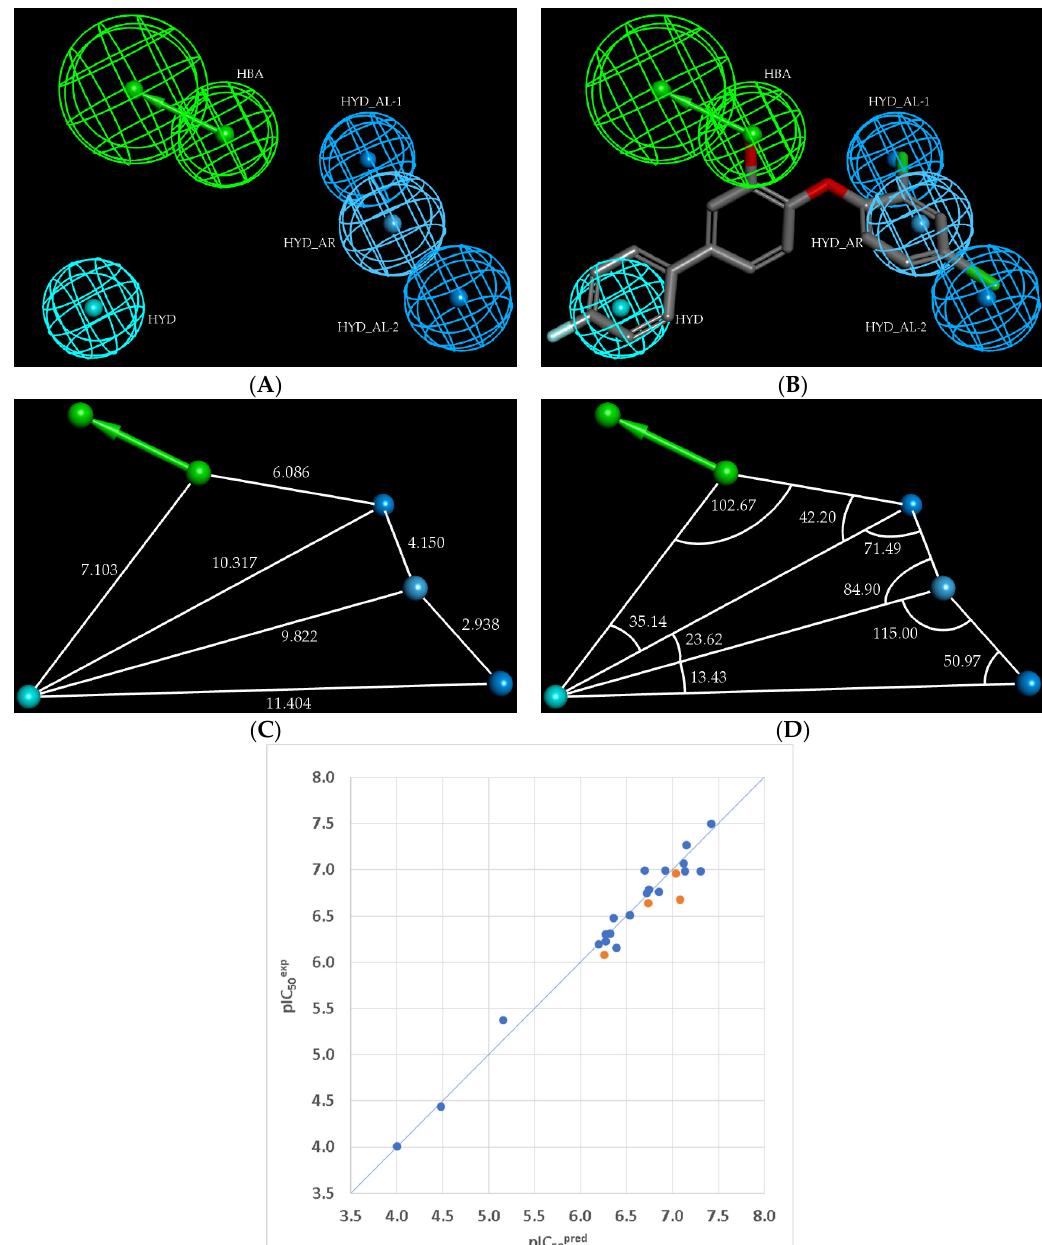
Figure 5. Features of the best PH4 model (Hypo1) of Pf ENR inhibitors generated by the 3D-QSAR pharmacophore module: ( A ) Coordinates of the centres, ( B ) mapping of Hypo1 with TCL15 (the most potent TCL molecule of the training set), ( C ) Distances in Å between the centres of the pharmacophoric features, ( D ) Angles (deg) between the centres. Colour code of features: blue—hydrophobic aliphatic; green—hydrogen bond acceptor; cyan—hydrophobic aromatic. ( E ) Plot of the linear correlation of experimental vs. predicted inhibitory activity (blue circles correspond to the training set and orange to the validation